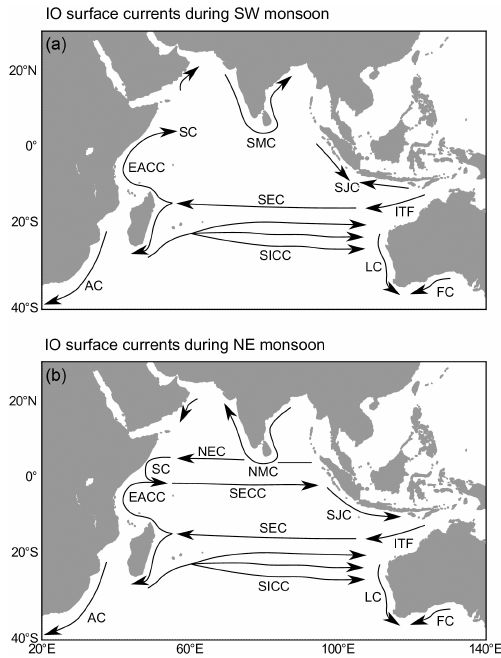
Figure 4. Schematic of ocean surface currents in the Indian Ocean based on Schott et al. (2009), during (a) the SW monsoon sea- son and (b) the NE monsoon season. The following currents are shown and labelled with abbreviations: Southwest Monsoon Cur- rent (SMC) and Northeast Monsoon Current (NMC); West Indian Coastal Current (WICC) and East Indian Coastal Current (EICC); Sri Lanka Dome (SLD); South Java Current (SJC); Indonesian Throughflow (ITF); Somali Current (SC); East African Coastal Cur- rent (EACC); North Equatorial Current (NEC); South Equatorial Counter Current (SECC); South Equatorial Current (SEC); Agul- has Current (AC); Leeuwin Current (LC); Flinders Current (FC); and South Indian Counter Current (SICC). The numbers in (a)